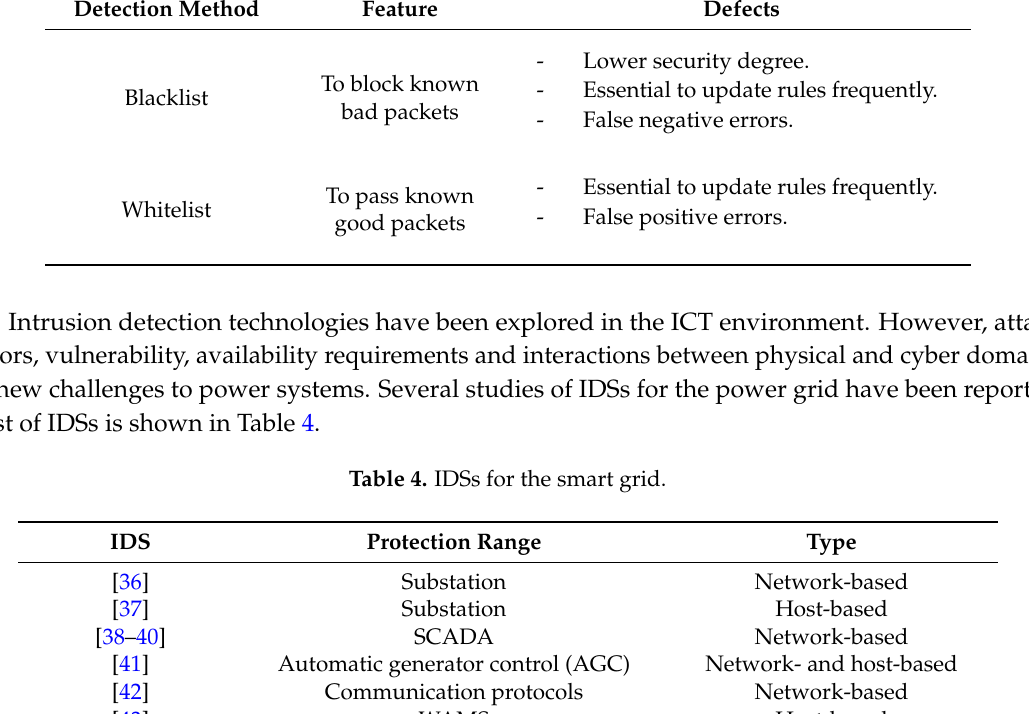
Table 3. A comparison of the detection methods.